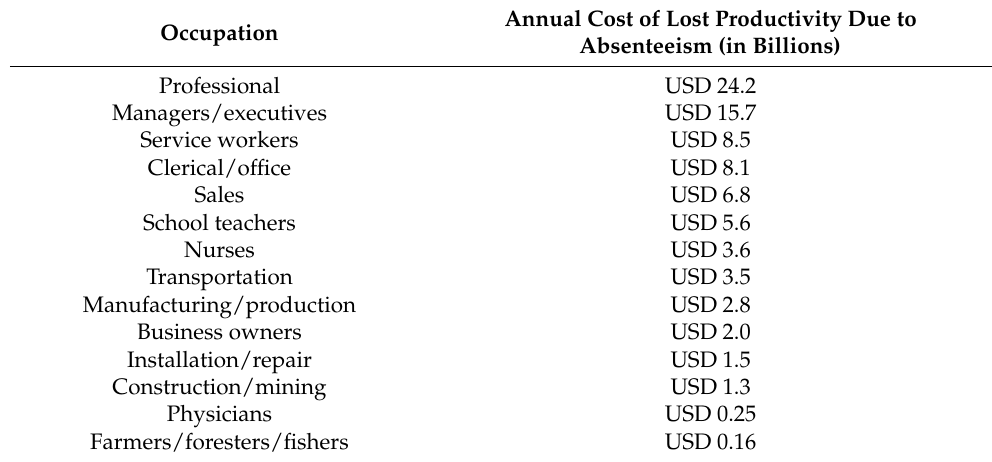
Table 1. The annual costs associated with absenteeism among different